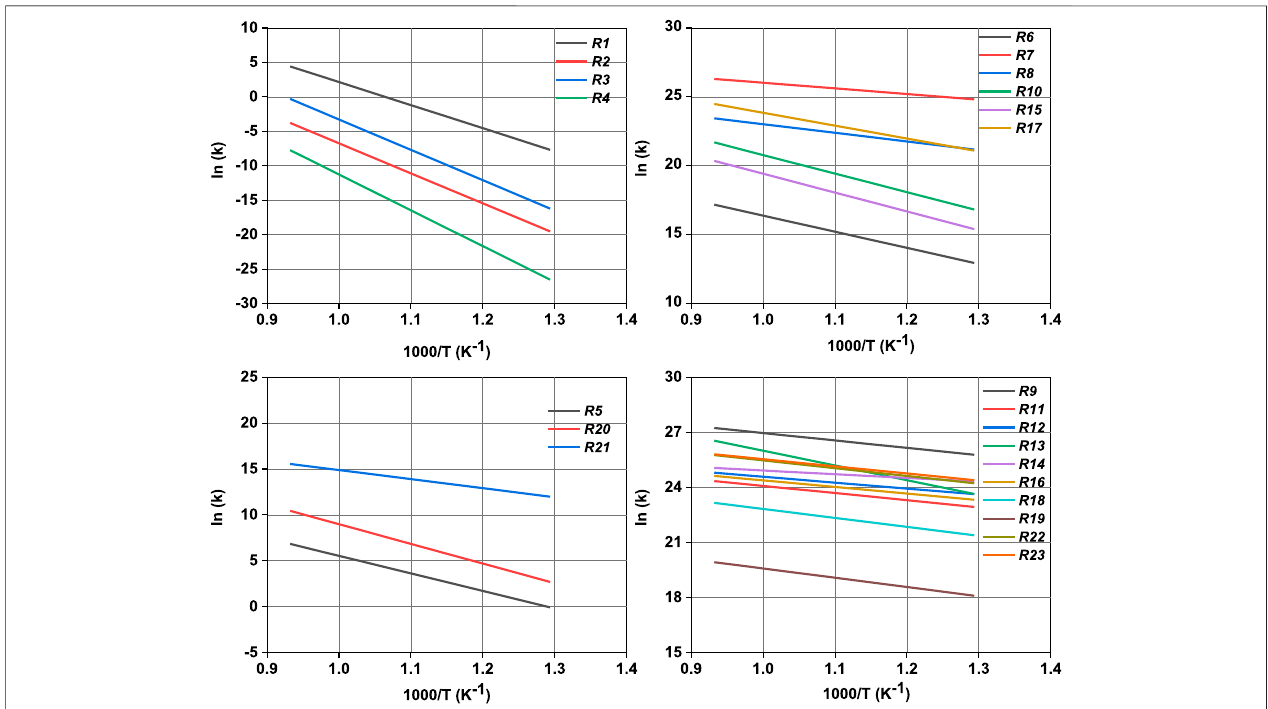
FIGURE 5 | Variation of rate constants of elementary steps at different pyrolysis temperatures.